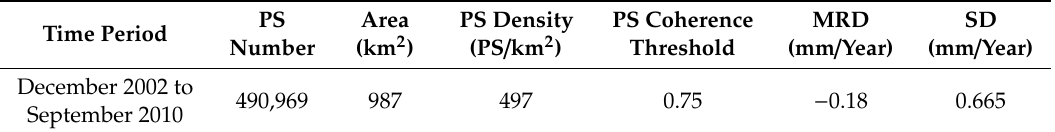
Table 3. Statics of PSInSAR (Persistent Scatterer InSAR) subsidence.